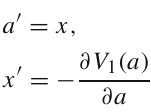
13 shows the phase portrait for positive (cid:3) γ , while Fig. 14 shows the phase portrait for negative (cid:3) γ